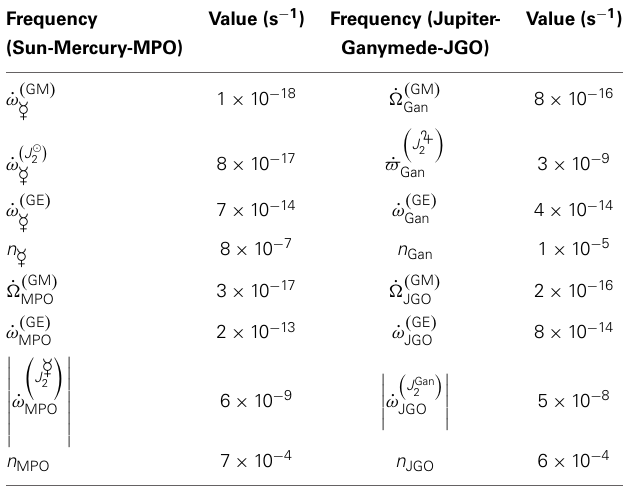
Table 1 | Some characteristic orbital frequencies, in s − 1 , of the Sun-Mercury-Mercury Planetary Orbiter (MPO) and of the Jupiter-Ganymede-Jupiter Ganymede Orbiter (JGO) (Grasset et al., 2013) systems.